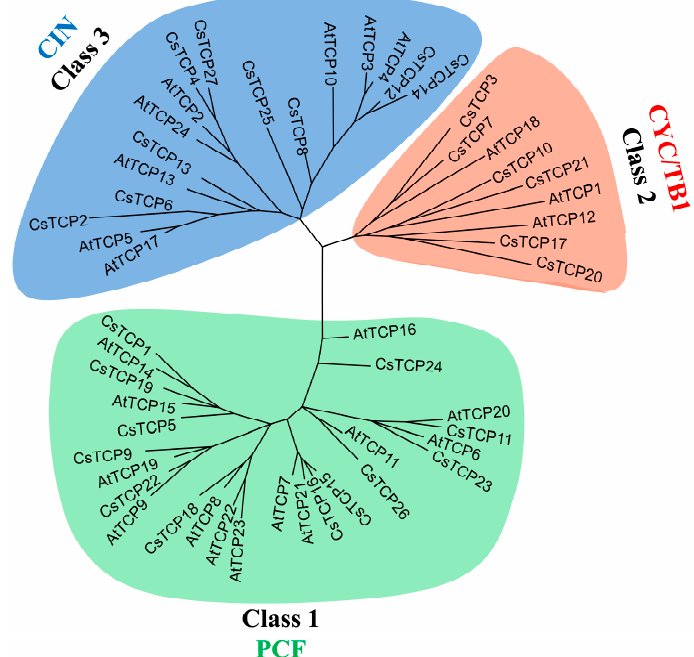
Figure 1. The phylogenetic tree of the total CsTCPs and AtTCPs. It was constructed in the MEGA 6.0 software with the Neighbor-Joining method. The bootstrap analysis was performed with 1000 iterations. Different colors represented different TCP classes, Class 1 (PCF), Class 2 (CYC/TB1) and Class 3